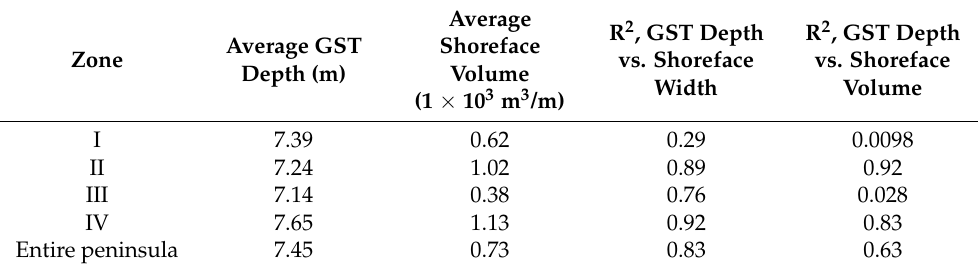
Table 1. Average geologic shoreface toe (GST) depth and average shoreface volume in each zone. Shoreface volume estimates are modified from Wei et al. [58]. Relationships between GST depth compared to shoreface width and shoreface